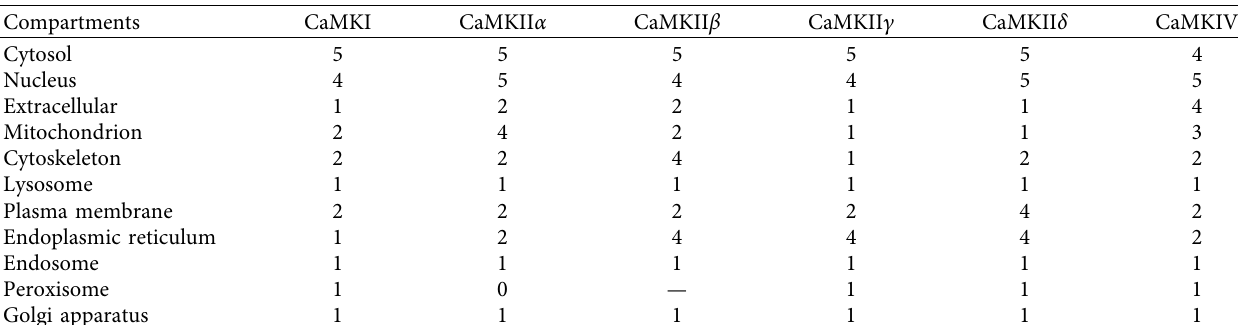
Table 1: Distribution of CaMKs in cell compartments. Te confdence values for each cell compartment are indicated. Te highest confdence for proteins of multifunctional CaMKs is in cytosol and nucleus, which are therefore assumed to be the subcellular com- partments richest in CaMKs. With the exception of endoplasmic reticulum reaching confdence value 4 for CaMII β , CaMKII c , and CaMK δ , the other organelles are at level 1, the lowest confdence level. Confdence values of cellular compartments are obtained from the GeneCards-the human gene database (https://www.genecards.org/)